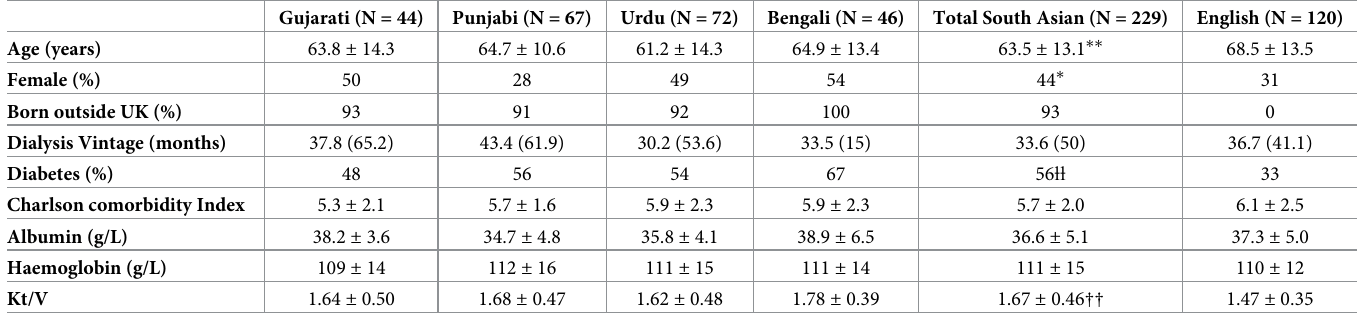
Table 2. Demographic and clinical characteristics. Continuous variables expressed as mean ± standard deviation or median (interquartile range) as appropriate. Cate- gorical variables expressed as percentages. * p = 0.016, ** p = 0.001, ††p <